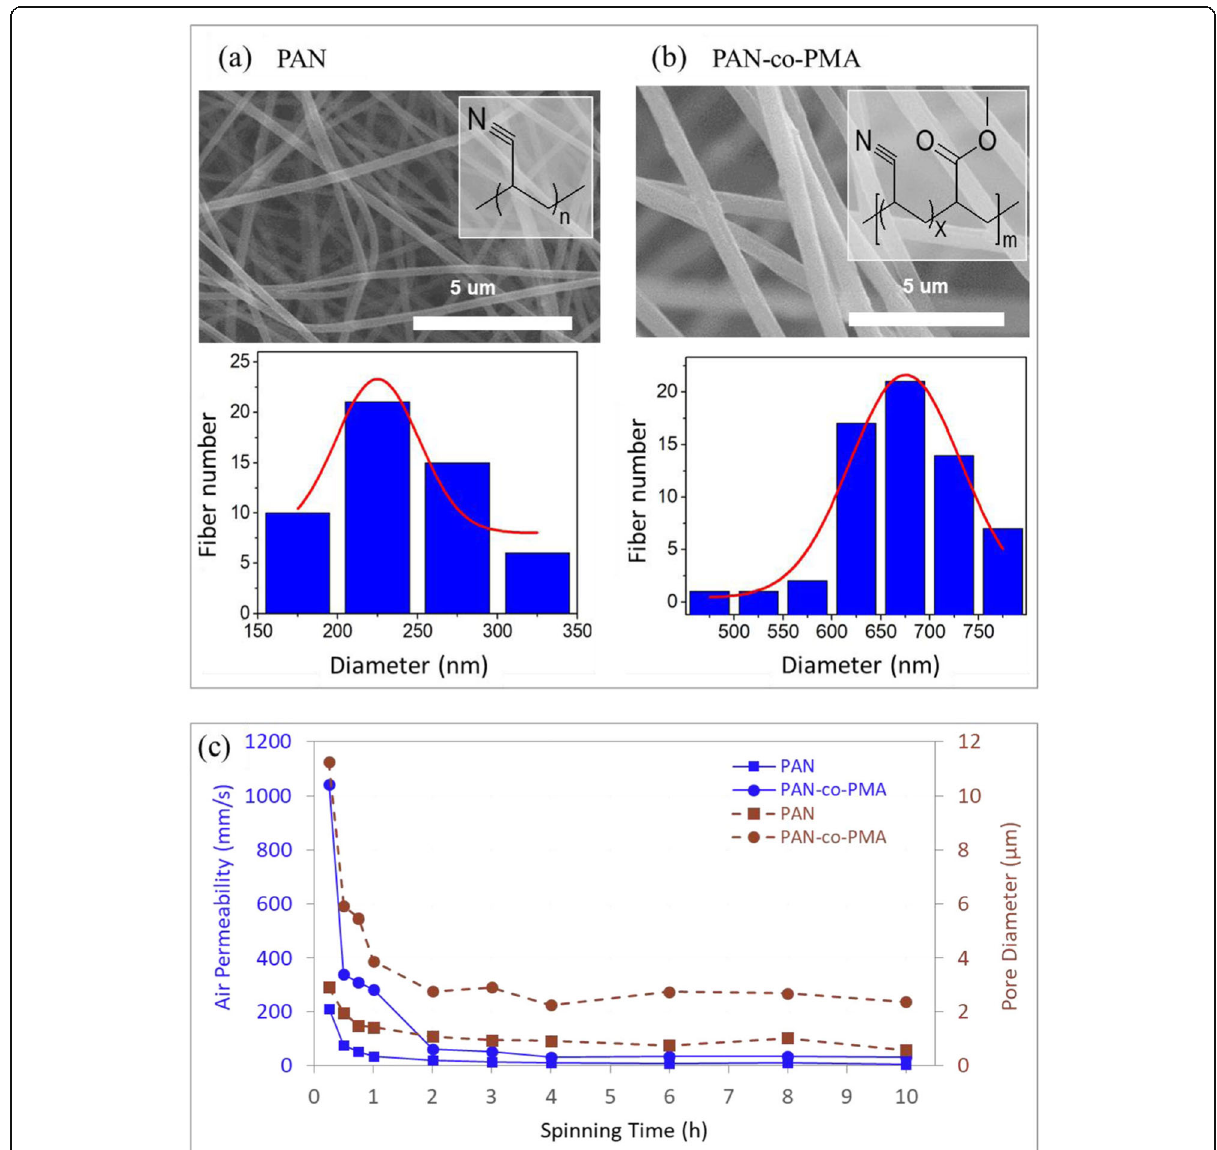
Fig. 3 Diameter distribution of different PAN type (3% TiO 2 ) nanofibers: ( a ) PAN:TiO 2 , ( b ) PAN-co-PMA:TiO 2 , and ( c ) average pore size and permeability of PAN:TiO 2 and PAN-co-PMA:TiO 2 nanofiber